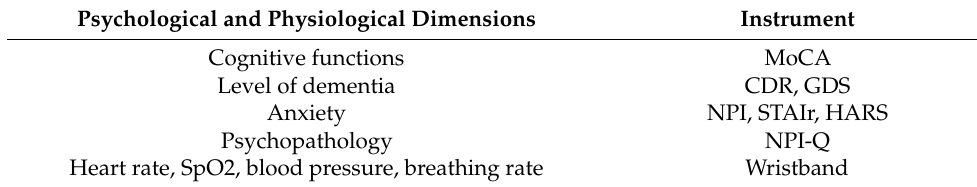
Table 2. Dimensions assessed and instruments